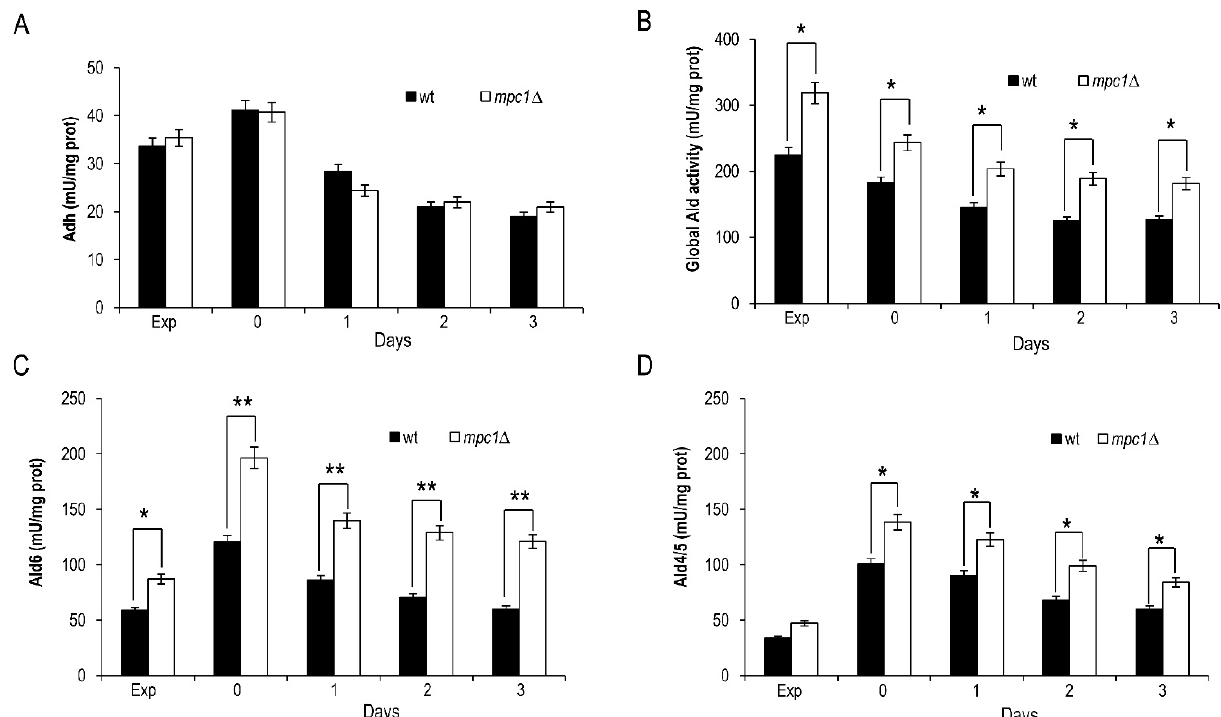
FIGURE 3: In mpc1 ∆ cells the extracellular abundance of acetate correlates with enhanced Ald enzymatic activity. Bar charts of total Adh (A), total Ald (B ), Ald6 (C) and Ald4/5 (D) enzymatic activities measured at the indicated time points for wt and mpc1Δ mutant cells grown as in Figure 2. Exp, exponential growth phase. Day 0, diauxic shift. Data refer to mean values determined in three independent experiments. SD is indicated. * P ≤ 0.05 and ** P ≤